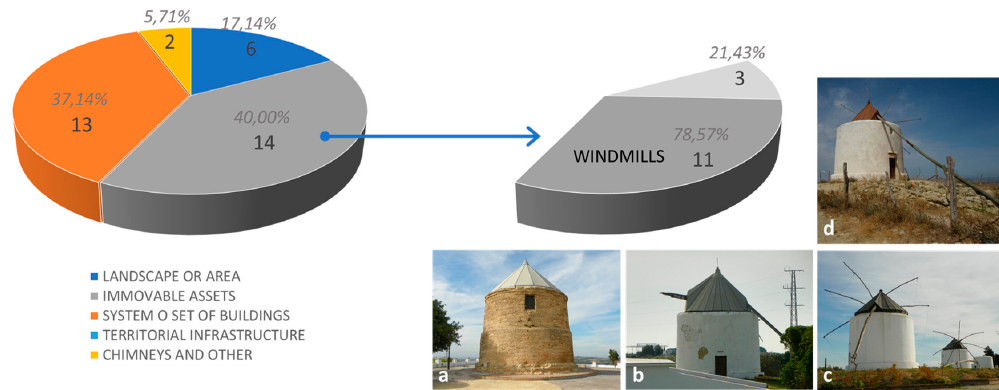
Figure 9. Distribution of assets for the scale criterion applied to the agroindustry assets identified in the Province of Cádiz. The presence of windmills and some examples in Vejer de la Frontera: ( a ) and ( b ) windmills at “Loma de la Buenavista”; ( c ) windmills that neighbor San José; ( d ) windmill “la Cruz de Conil”.